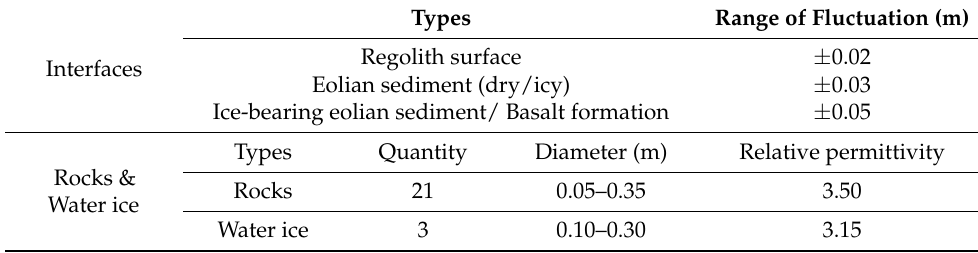
Figure 1. The 3D realistic structure model of Utopia Planitia. Table 1. Parameters of the 3D realistic structure model.